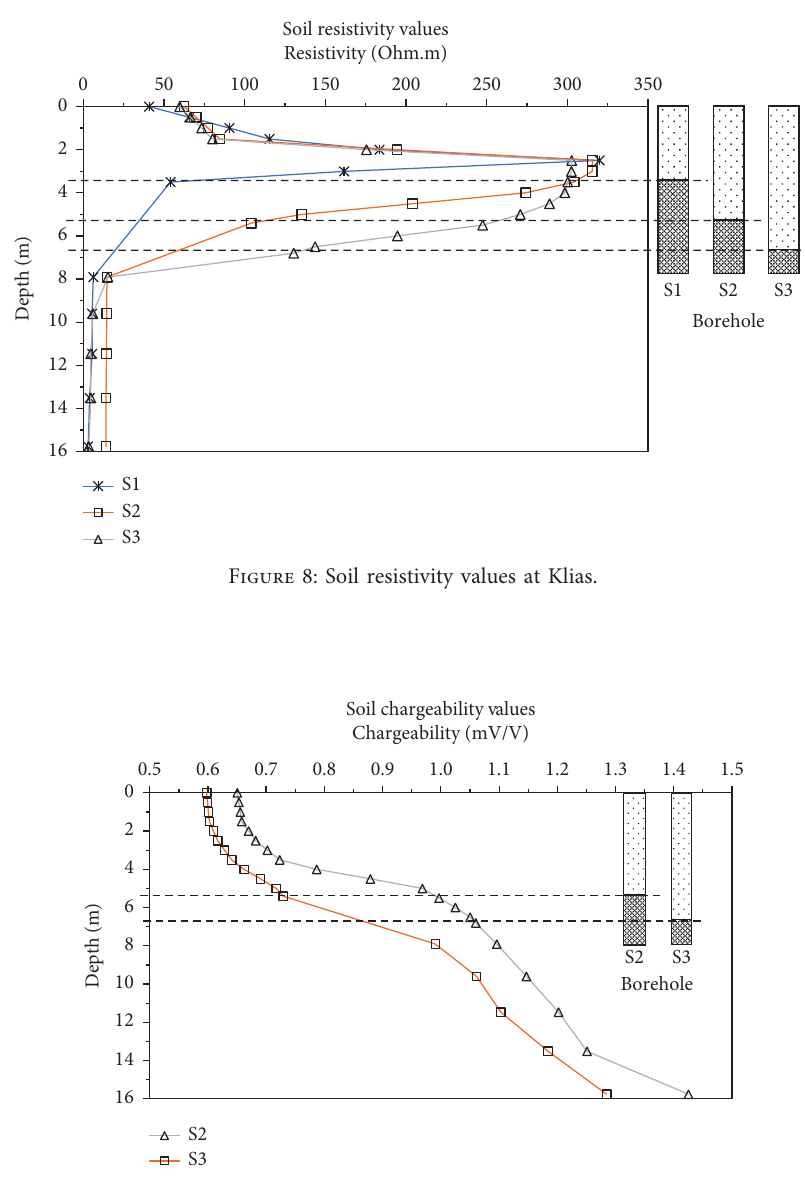
Figure 9: Soil chargeability values at